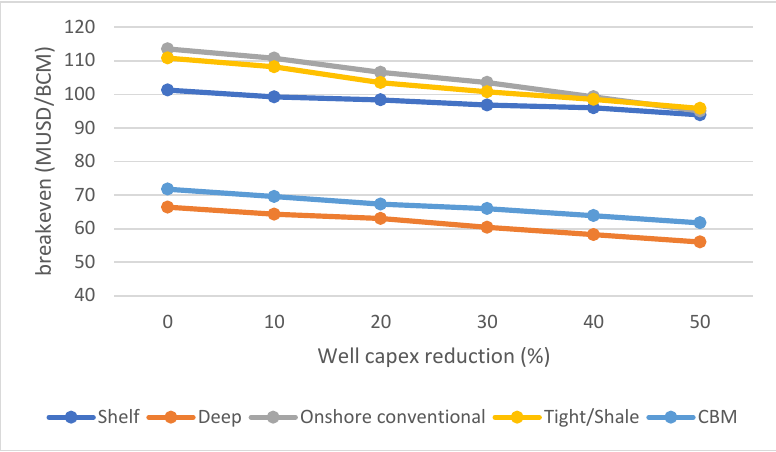
Figure 7. Initial breakeven price as a function of well capex reduction.